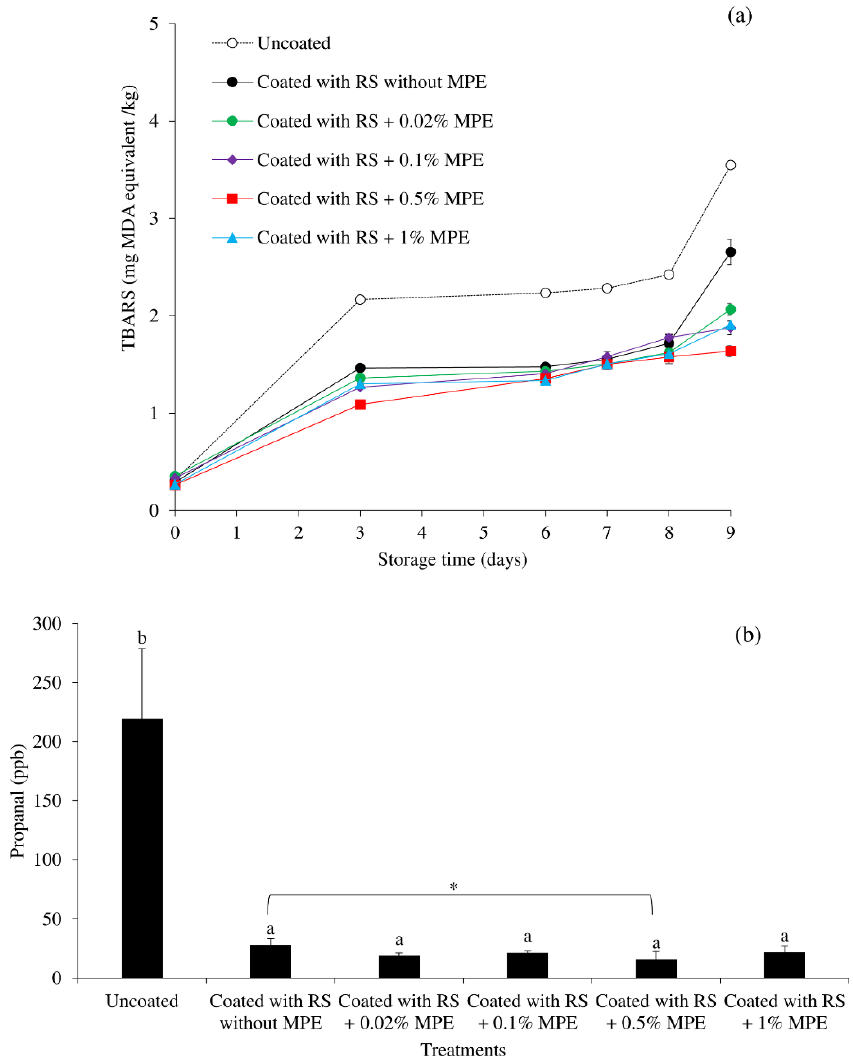
Figure 2. Changes in the thiobarbituric acid reactive substances (TBARS) of mackerel slices over the course of storage at 4 °C as influenced by coating with rice starch (RS) containing Mon-pu extract (MPE) at different concentrations ( a ), and the propanal content of mackerel slices coated with RS containing MPE at different concentrations at Day 9 of storage at 4 °C ( b ). Bars represent standard deviation from triplicate determinations. Different letters on the bars indicate significant differences ( p < 0.05). The difference between coated samples with a p < 0.05 is indicated by an asterisk (*).